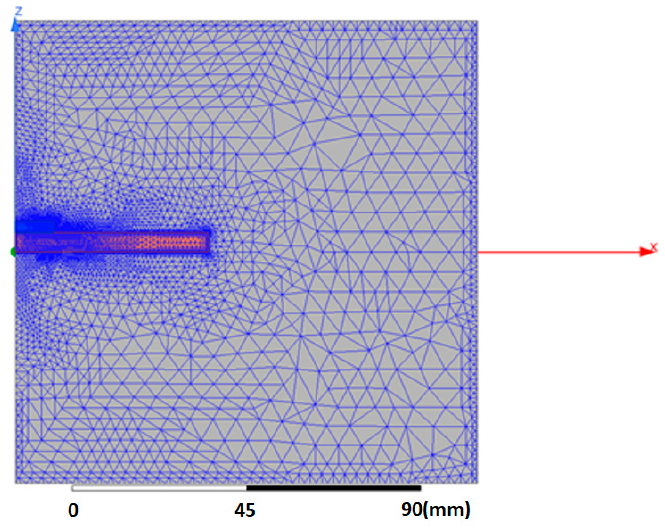
Figure 9. An image of a computer network model.